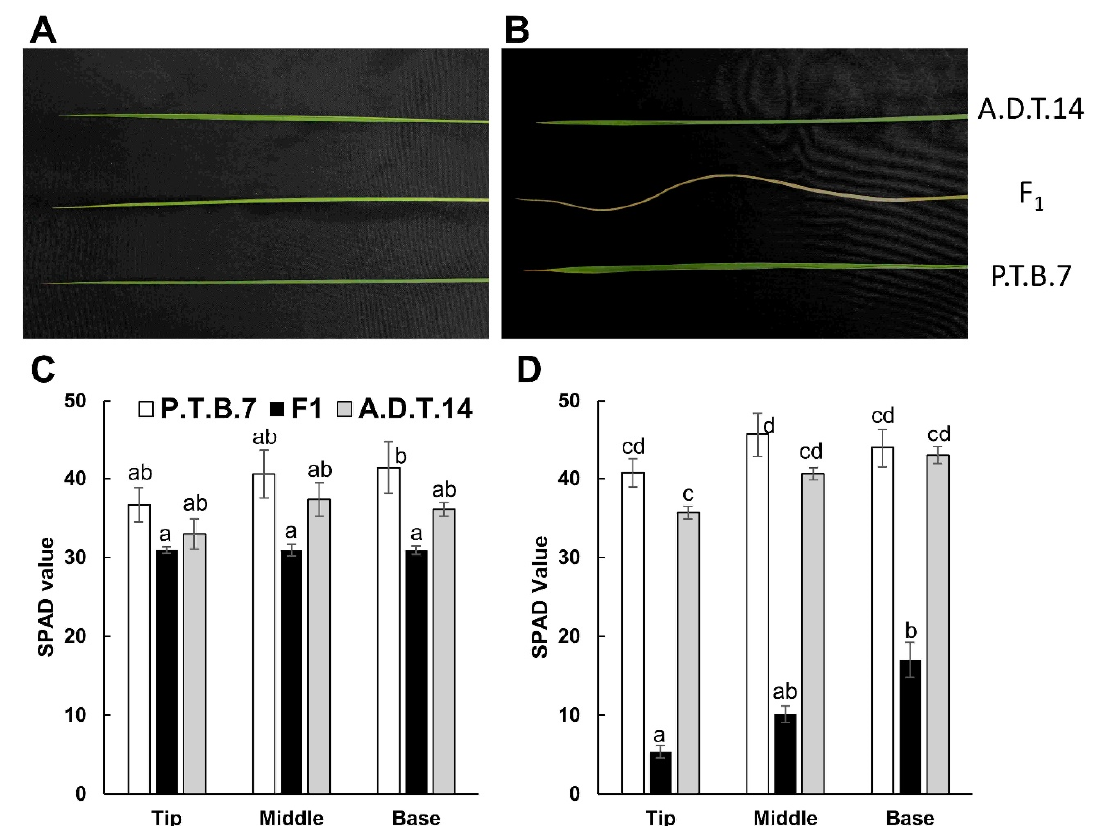
Figure 7. Phenotypes and SPAD values of the parental and F 1 leaves (11th and 13th) used for gene expression analysis. The phenotypes ( A , B ) and SPAD values ( C , D ) of 11th ( A , C ) and 13th ( B , D ) leaves were assessed at 70 d after sowing. SPAD value was measured at the tip, middle, and base of each leaf. Values and error bars indicate mean ± SE values ( n = 3), and different lowercase letters in each plot ( C , D ) indicate significant differences (Tukey HSD test, P < 0.05).